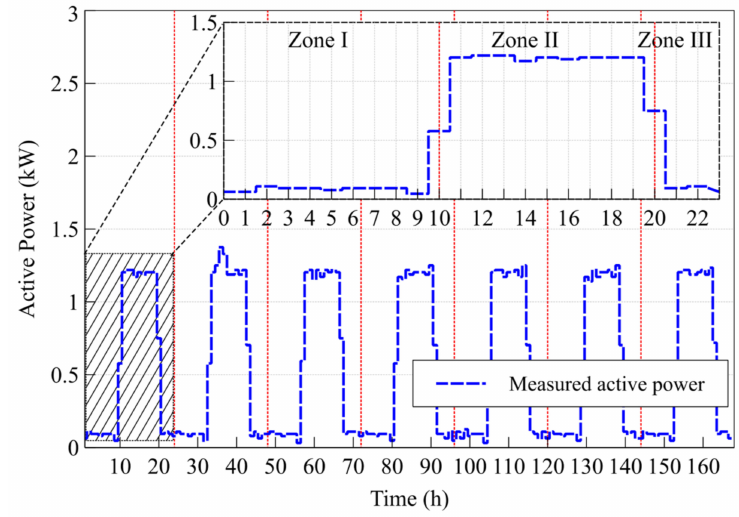
Figure 5. Active power consumption of the V í tor SPP for one working